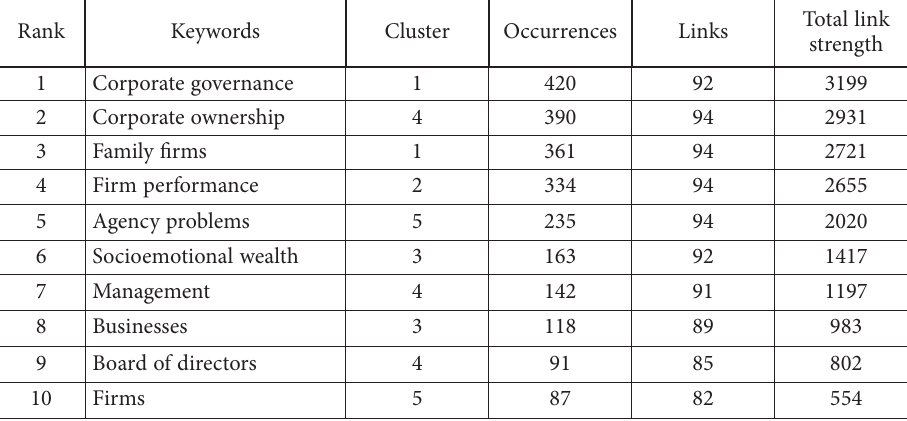
Table 5. The top 10 keywords in the occurrence